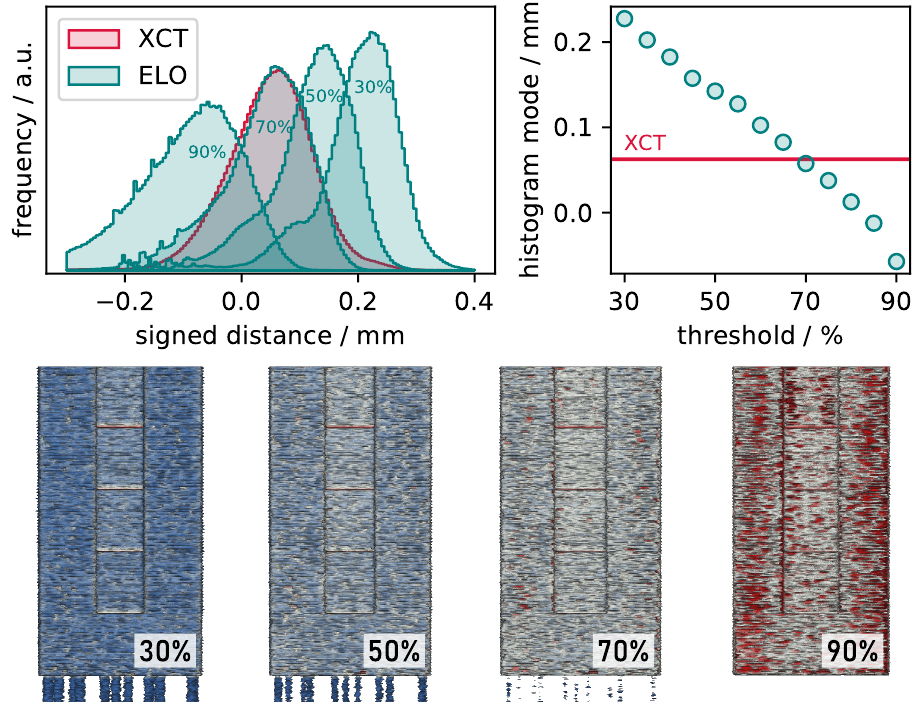
Figure A1. Signed distance analysis of part A for different ELO